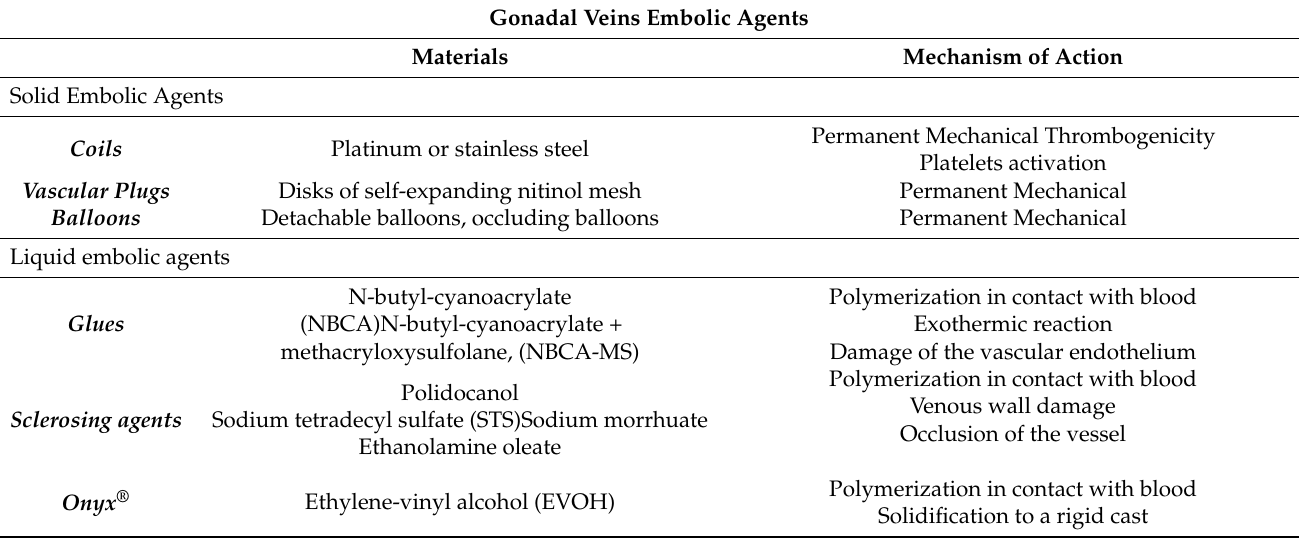
Table 1. This table summarizes embolic agents used in gonadal veins